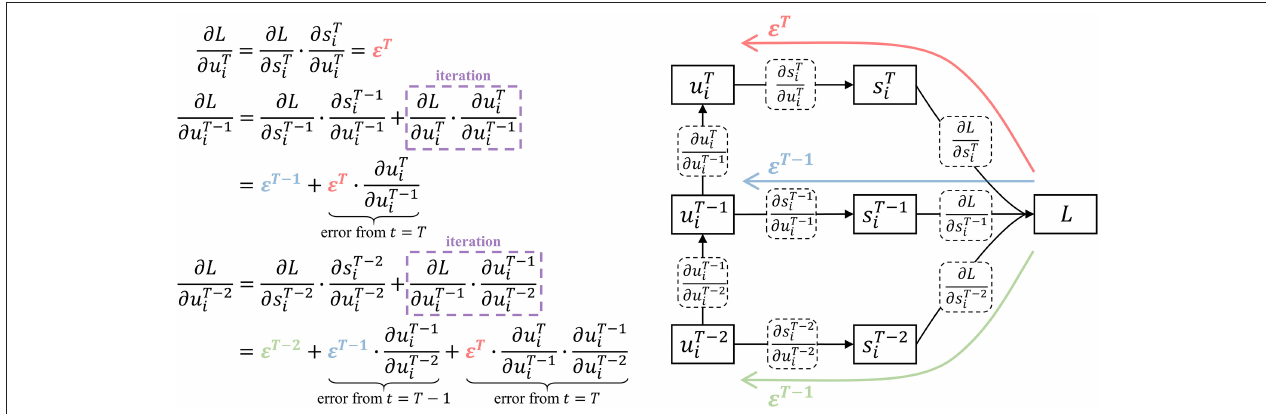
1, the potential error includes −